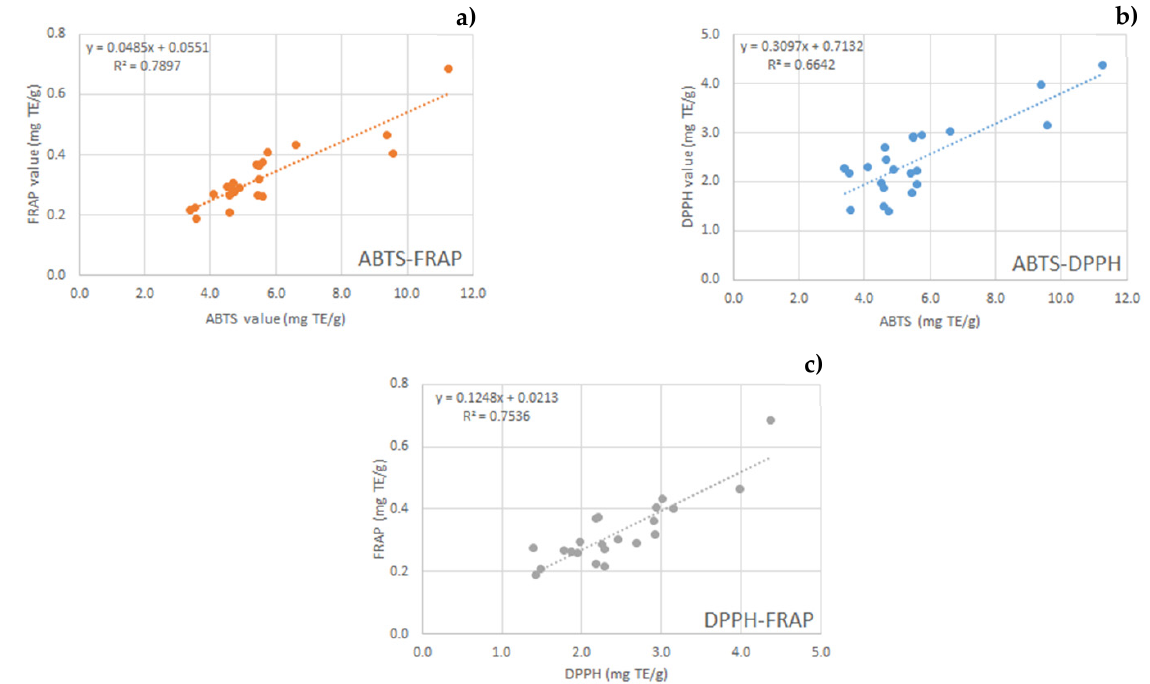
Figure 2. Correlations between values of antioxidant activity assays (ABTS, DPPH, FRAP) of all extracts. Correlation between ABTS and FRAP ( a ); correlation between ABTS and DPPH ( b ); correlation between DPPH and FRAP ( c ).